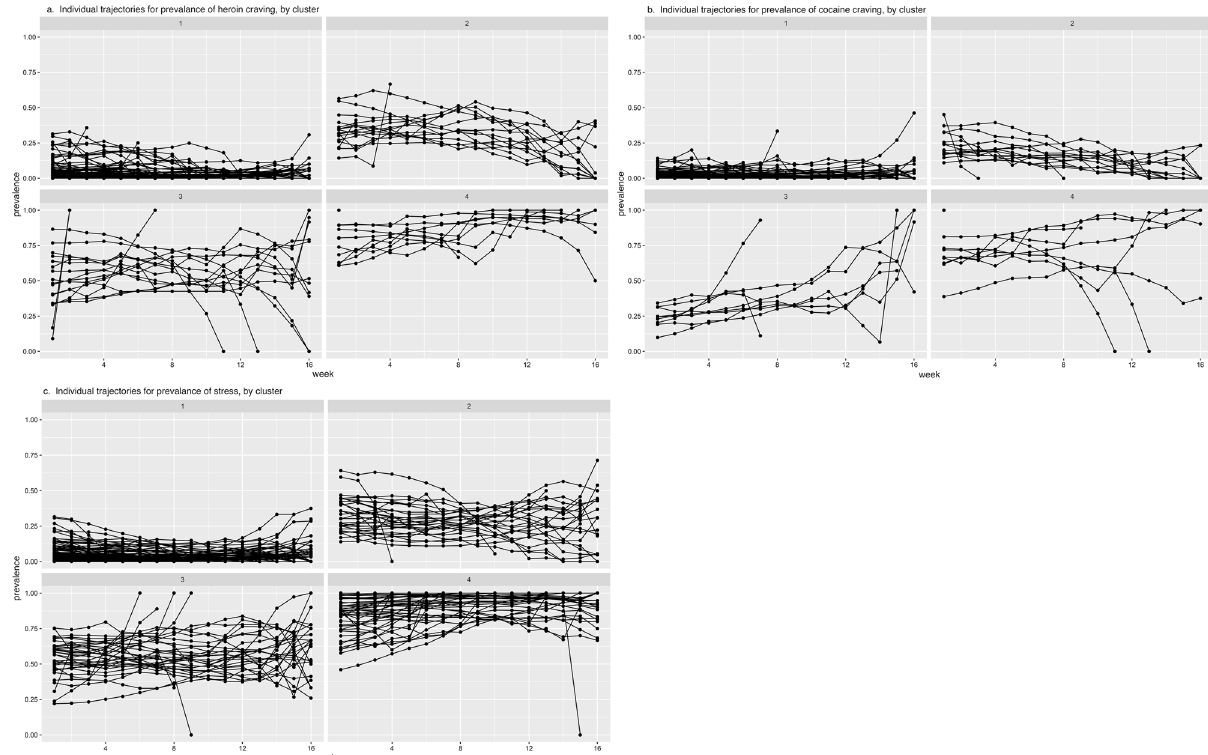
Fig. 7 Individual participants ’ trajectories of prevalence for heroin craving, cocaine craving, and stress, by cluster. The clusters are the same as those in Fig.